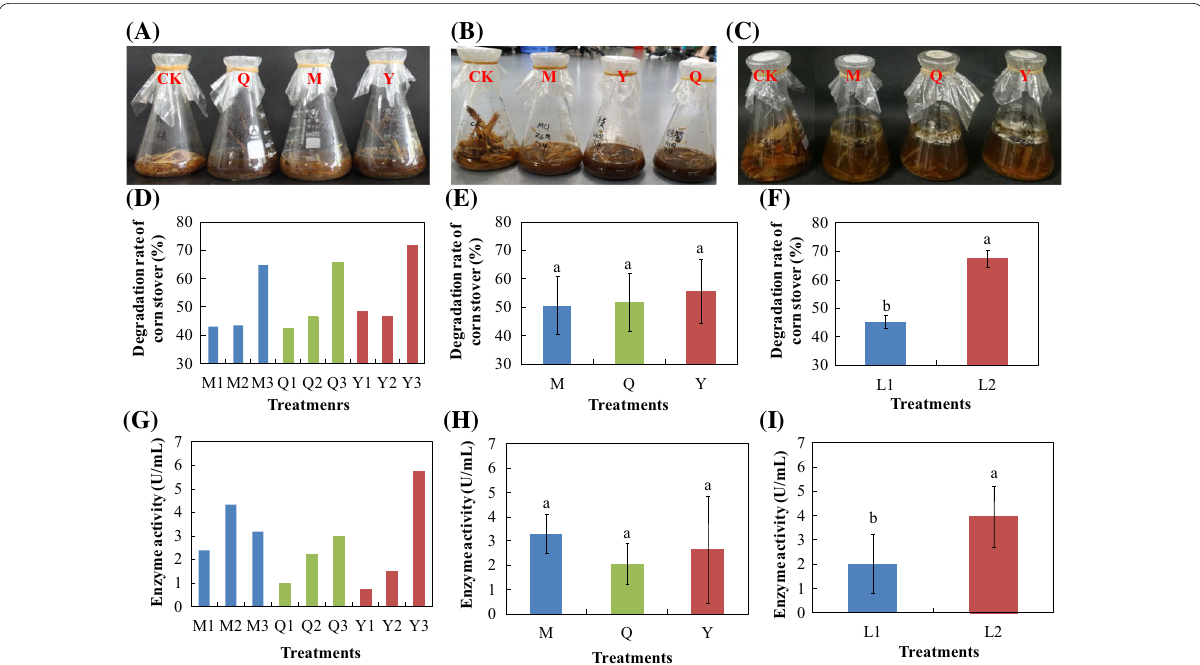
Fig. 1 Degradation experiment of the first ( A ), second ( B ), and third ( C ) generation and the effect of treatments ( D / G ), microflora sources ( E / H ), and liquid volume ( F / I ) on corn stover degradation ( D / E / F ) and endo-glucanase activity ( G / H / I ). M, microbial consortia source from MC1; Q, microbial consortia source from MC1, sheep, and cattle feces; Y, microbial consortia source from sheep feces; L1, 100 mL PCS medium; L2, 200 mL PCS medium. Values followed by different letters are significantly different at P < 0.05